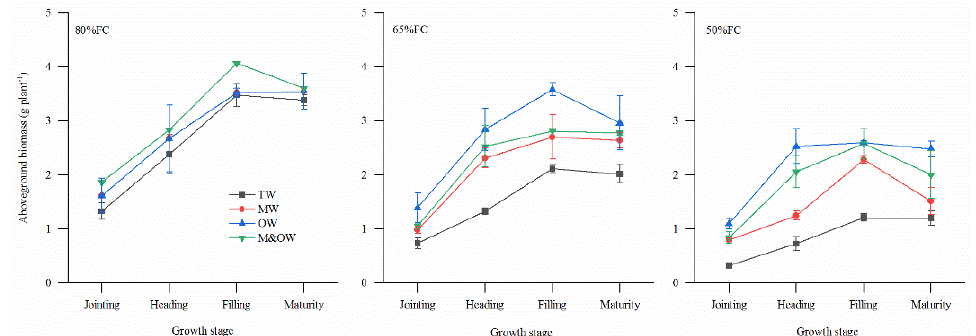
Figure 4. Effect of tap water (TW), magnetized water (MW), oxygenated water (OW), and magnetized and oxygenated water (M&OW) irrigation on aboveground biomass of winter wheat with 80%FC, 65%FC, and 50%FC irrigation amounts in the different growth stages. The error bars indicate standard deviations.